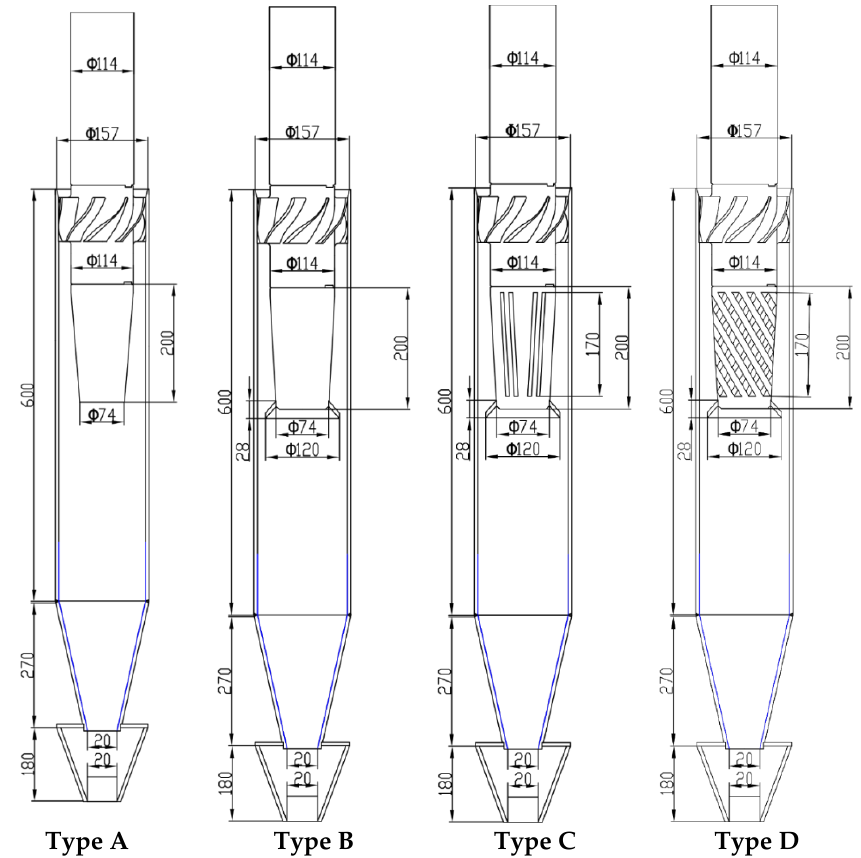
Figure 18. Geometries of the vortex finders.